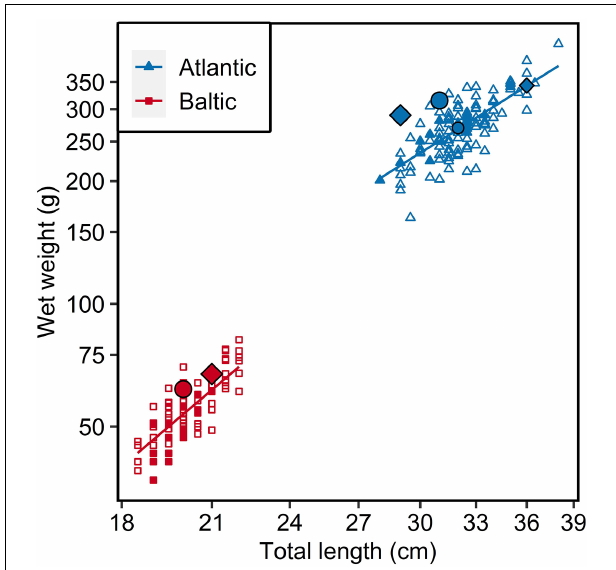
FIGURE 1 | Length-weight relationship of Atlantic ( N = 97) and Baltic ( N = 48) parental herring. Filled points represent individuals used for otoliths analysis (17 individuals from each parental population), largest points represent main parental fish (Diamond = female; circle = male) used in crossing, medium sized points represent additional parents used for 6 psu group in tank 1. Fitted lines represent regressions from statistical model on logarithmic values.